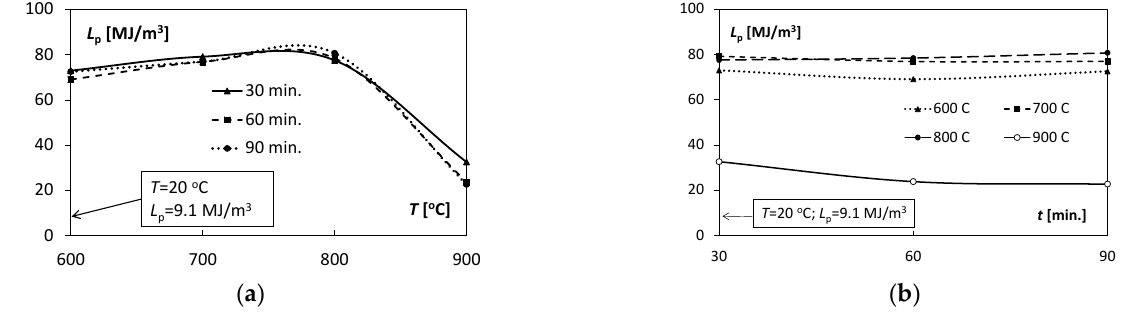
Figure 9. Variability of the uniform plastic strain energy per unit volume L p depending on: ( a ) temperature T , ( b ) annealing time t .